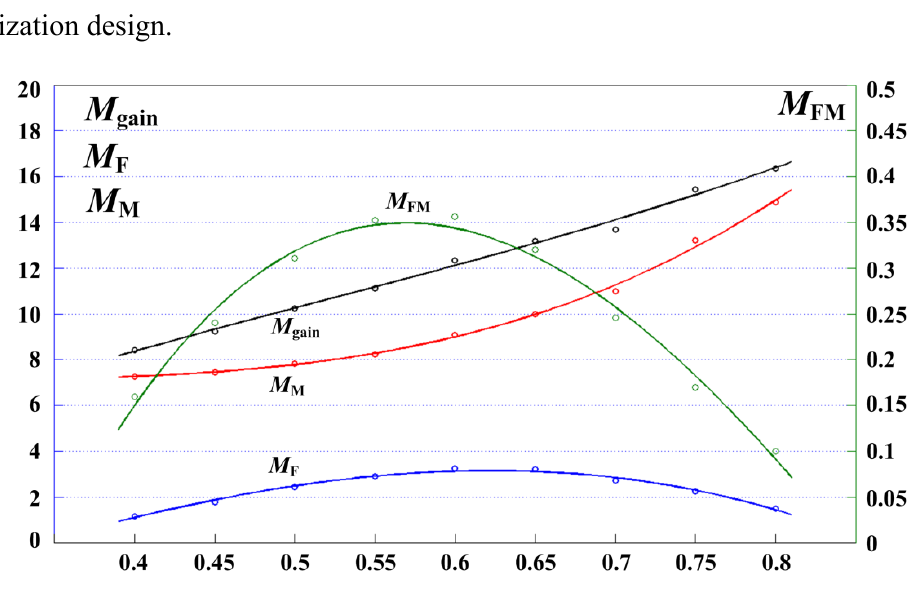
Figure 17. Relationship of M FM and voltage gain of V F , V M and V bus against D at L k = 18 μ